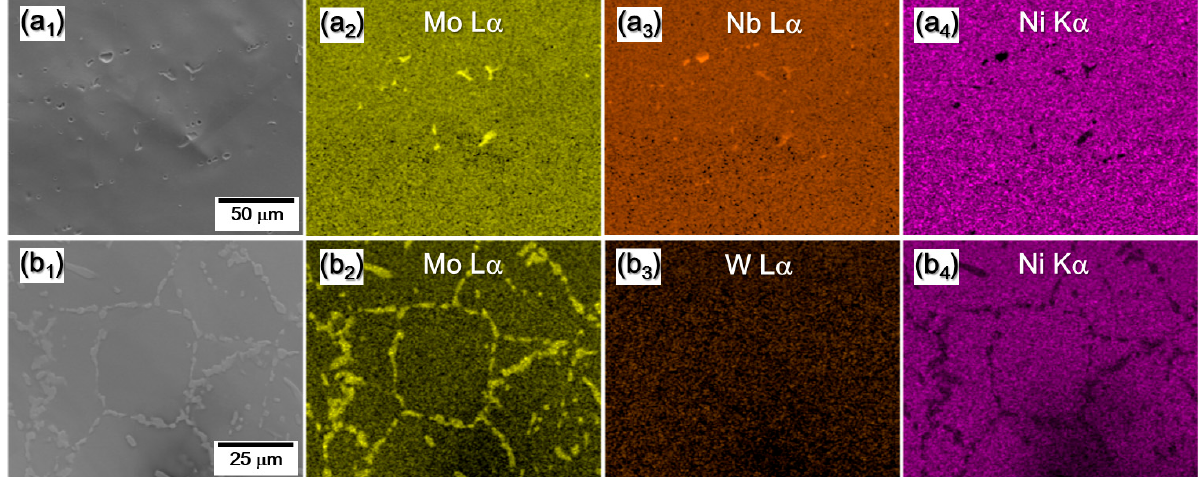
Figure 3. Distributions of the characteristic elements analyzed by SEM and the EDS elemental mapping of specimens ( a 1 – a 4 ) #2 and ( b 1 – b 4 ) #4.